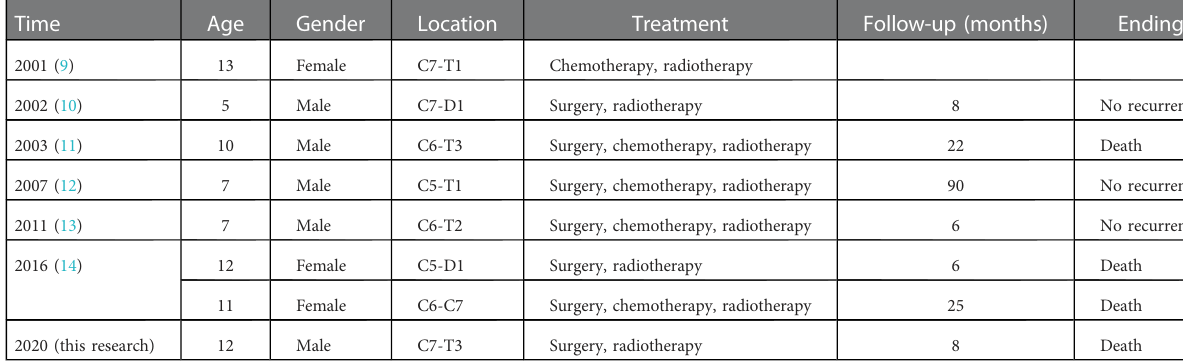
TABLE 1 Case data of ESS/PNET at the cervicothoracic junction in children. Time Age Gender Location Treatment Follow-up (months)